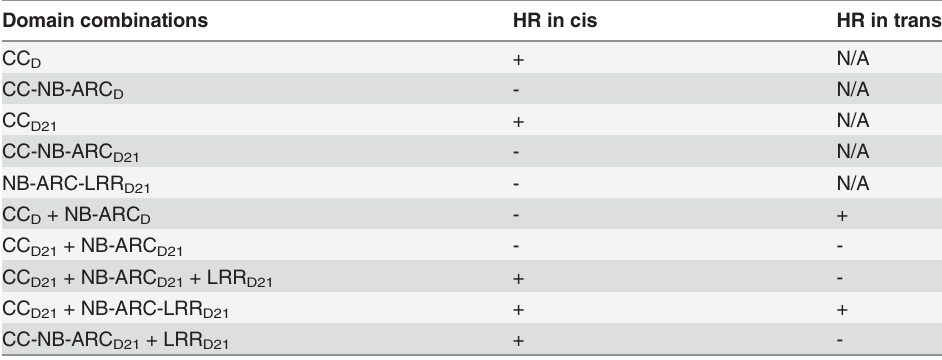
All constructs are tagged with EGFP at the C-terminus. +: HR; -: without HR; N/A: not